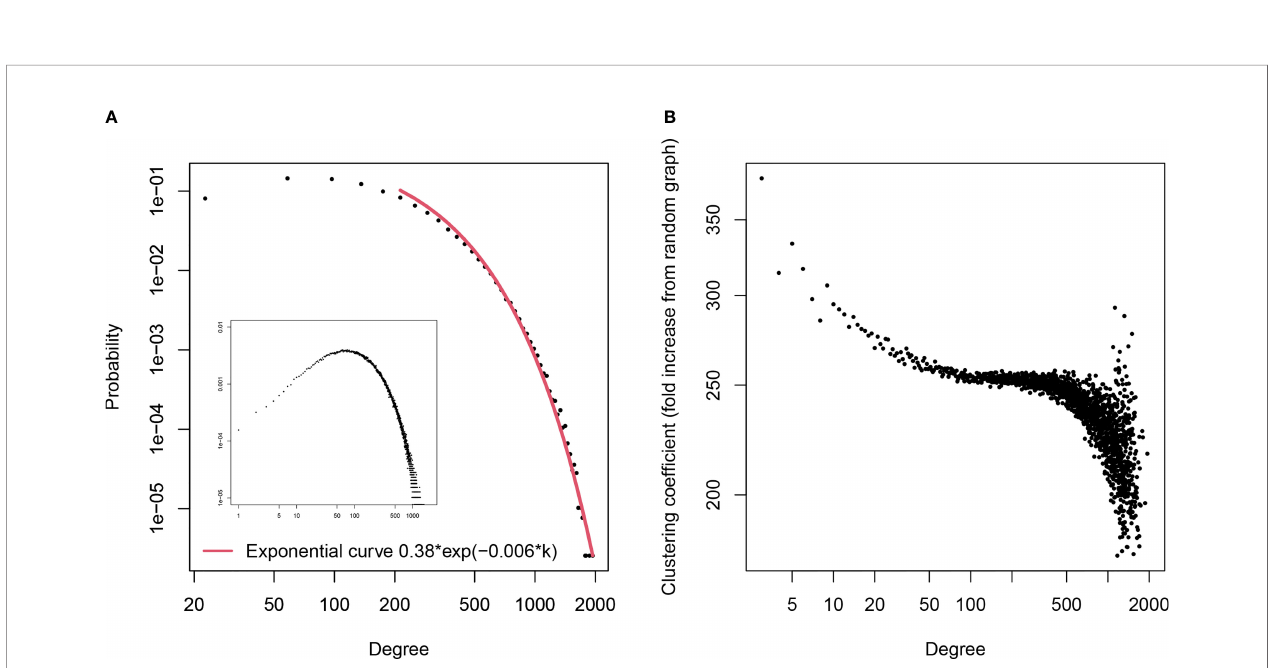
FIGURE 5 | (A) - Distribution of the degrees in the graph of the pooled mimotopes from libraries A and C The distribution was plotted using bins splitting the degree range in 50 equal ranges (linear bins) rather than the discrete degree values. The distribution is exponential (R 2 = 0.99, p<10 -7 ). The distribution plot based on the degree values without binning is shown in the inset. This type of degree distribution is consistent with a network evolving in time by random (non-preferential) attachment which can be a sign of positive selection of the IgM repertoire of speci fi cities. (B) – dependence of local clustering coef fi cient on degree. The clustering coef fi cient decreasing with degree and much higher than the expected level of mean(degree)/size of network is a con fi rmation that the graph is not randomly connected but an evolving network with the newer speci fi cities related to the older